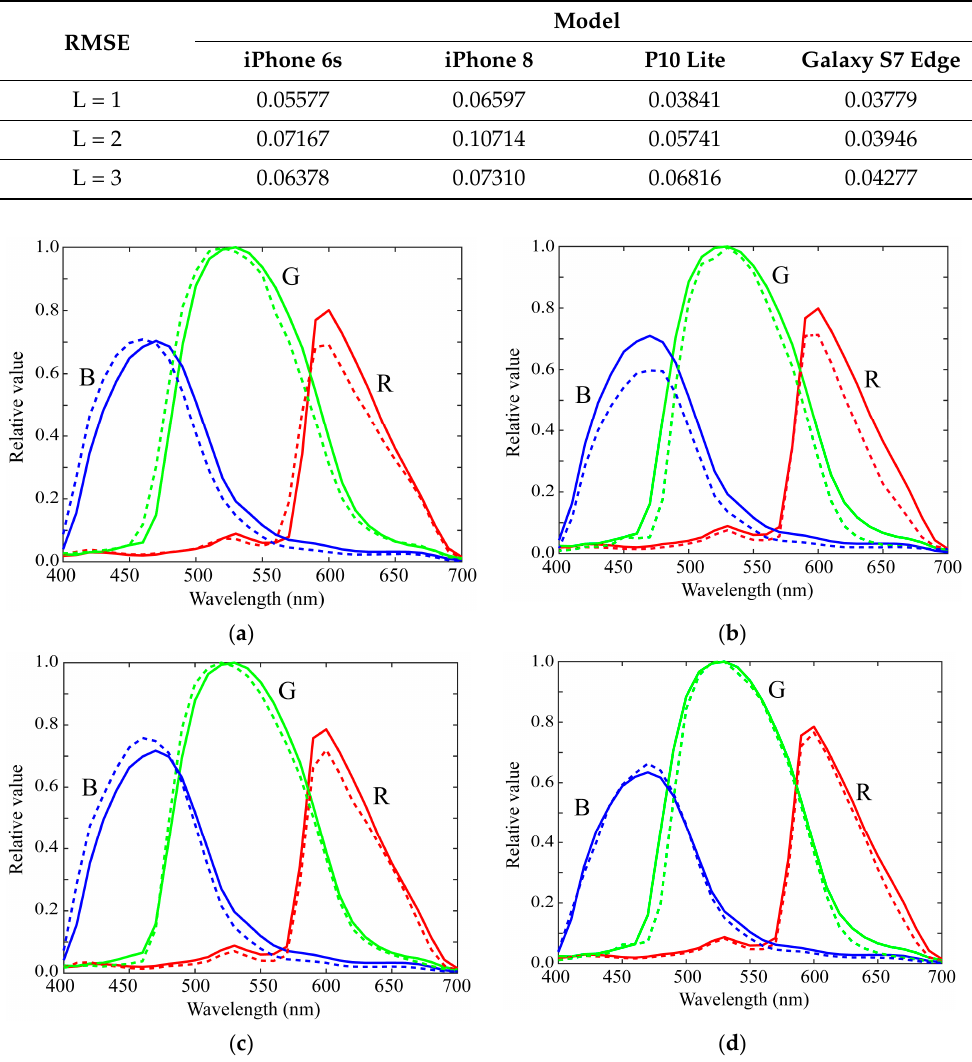
Figure 16. Estimated spectral sensitivities of ( a ) iPhone 6s, ( b ) iPhone 8, ( c ) P10 lite, and ( d ) Galaxy S7 edge at L = 1 using the 24 color checkers, where the bold and broken curves represent the estimated spectral sensitivities and the measured spectral sensitivities, respectively.